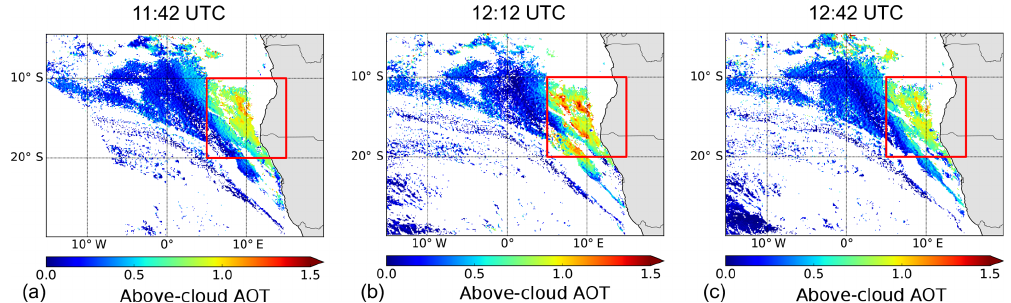
Figure 12. Above-cloud AOT retrieved on 5 September 2017 at 11:42, 12:12 and 12:42UTC. The red square represents the area over which the SEVIRI products have been